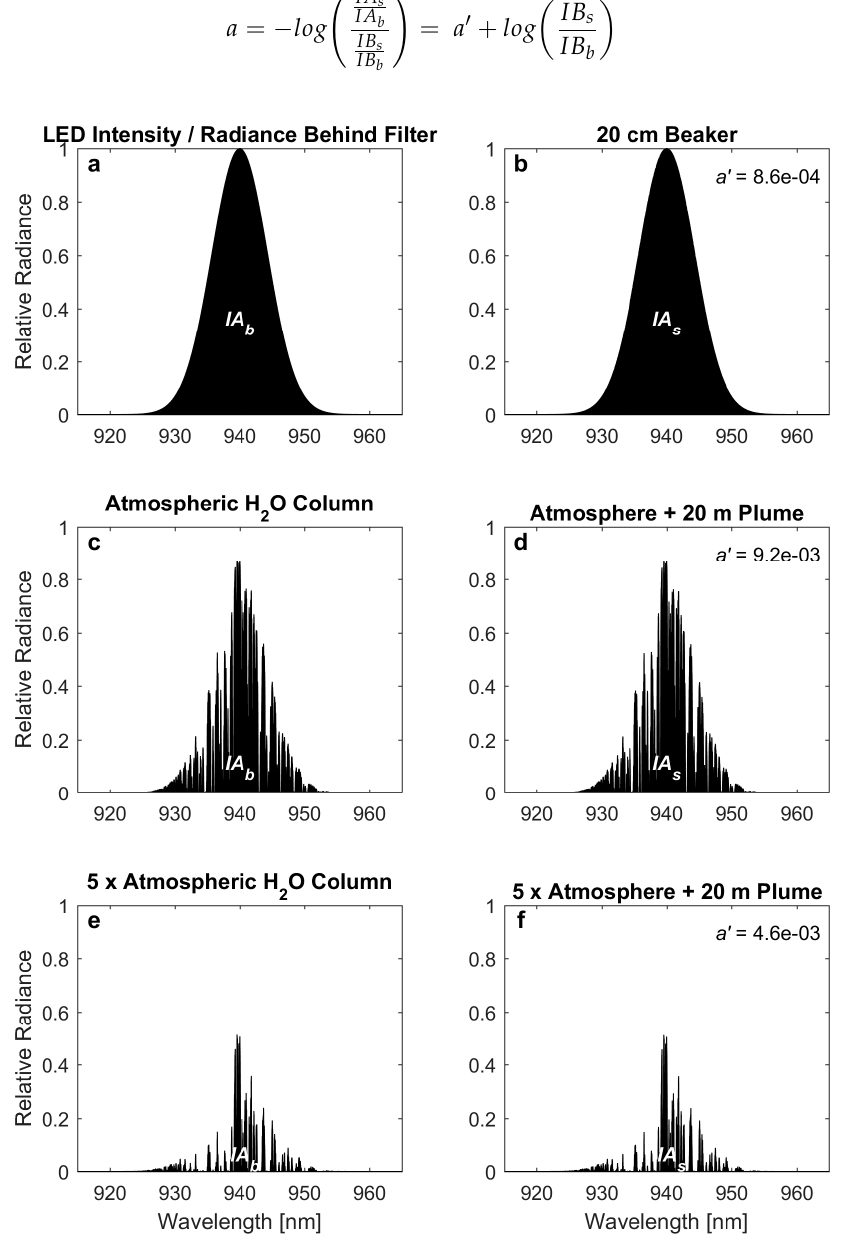
Figure 2. Radiance behind a bandpass filter with various amounts of water vapor in the measurement light path. These plots were calculated according to Equation (1). The Gaussian depicted in ( a ) represents the radiance emitted from a light emitting diode (LED) or the intensity measured behind an illuminated bandpass filter centered at 940 nm. In ( b ), the spectral radiance is decreased due to absorption by 100% relative humidity along a 20-cm path. Inset ( c ) shows the radiance obtained after absorption by H 2 O in a standard atmospheric column. In inset ( d ), the absorption by 100% relative humidity along a 20-m plume was added to the atmospheric absorption. Insets ( e ) and ( f ) show the same calculation, this time assuming that the background light has passed through the vertical column of H 2 O five times. The integral of each plot gives the total measured intensities IA b and IA s , respectively, and the optical depth a’ can be calculated from these (Equation (3)). In each of the three examined cases, absorption by the plume is almost negligible when compared to the atmosphere, and the expected optical depths associated with the plume are less than 1%.